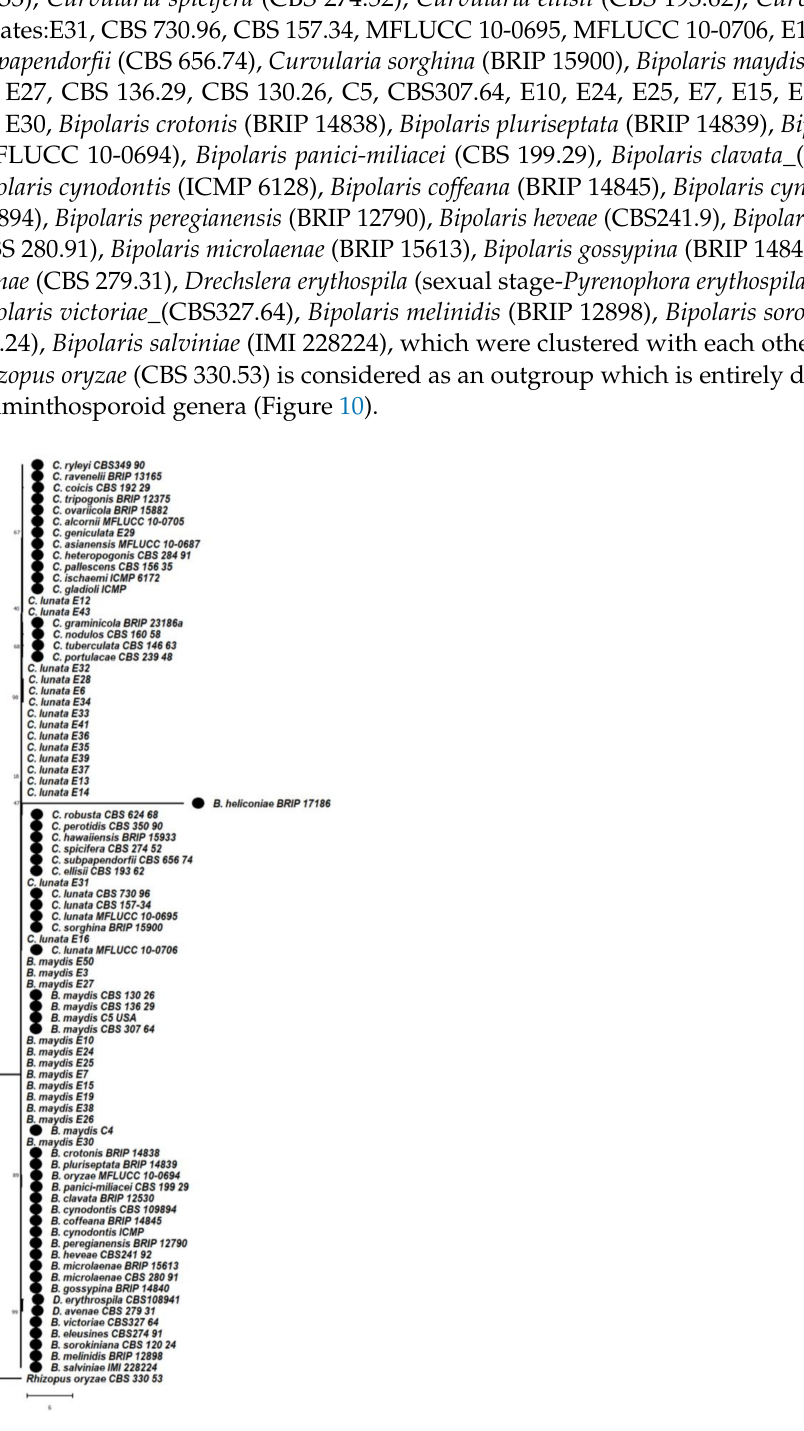
Figure 10. Maximum likelihood phylogeny based on combined internal transcribed spacer (ITS) and large subunit gene regions (LSU). Sequenced data of the Bipolaris maydis , and Curvularia lunata